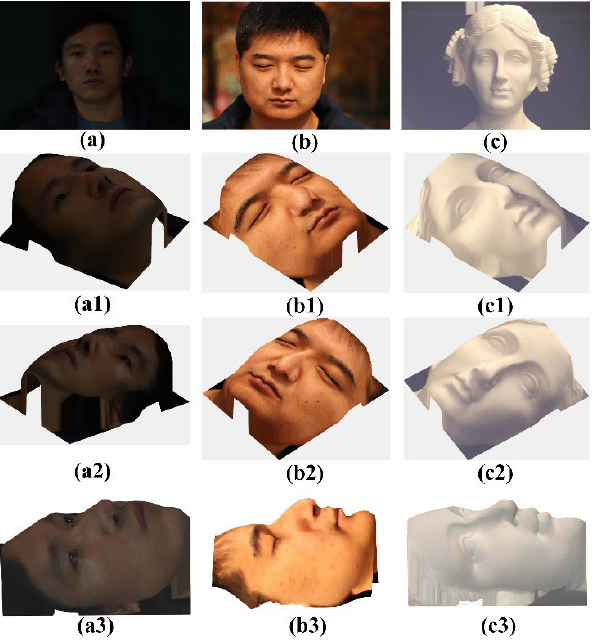
Figure 8. Three-dimensional face reconstruction using the developed method. ( a ) Indoor lighting of a male face, ( b ) outdoor natural illumination of a male face, ( c ) indoor lighting of a plaster statue, ( a1 – a3 ) Three different views of recovered 3D face of ( a ), ( b1 – b3 ) Three different views of recovered 3D face of ( b ), ( c1 – c3 ) Three different views of recovered 3D face of ( c ).